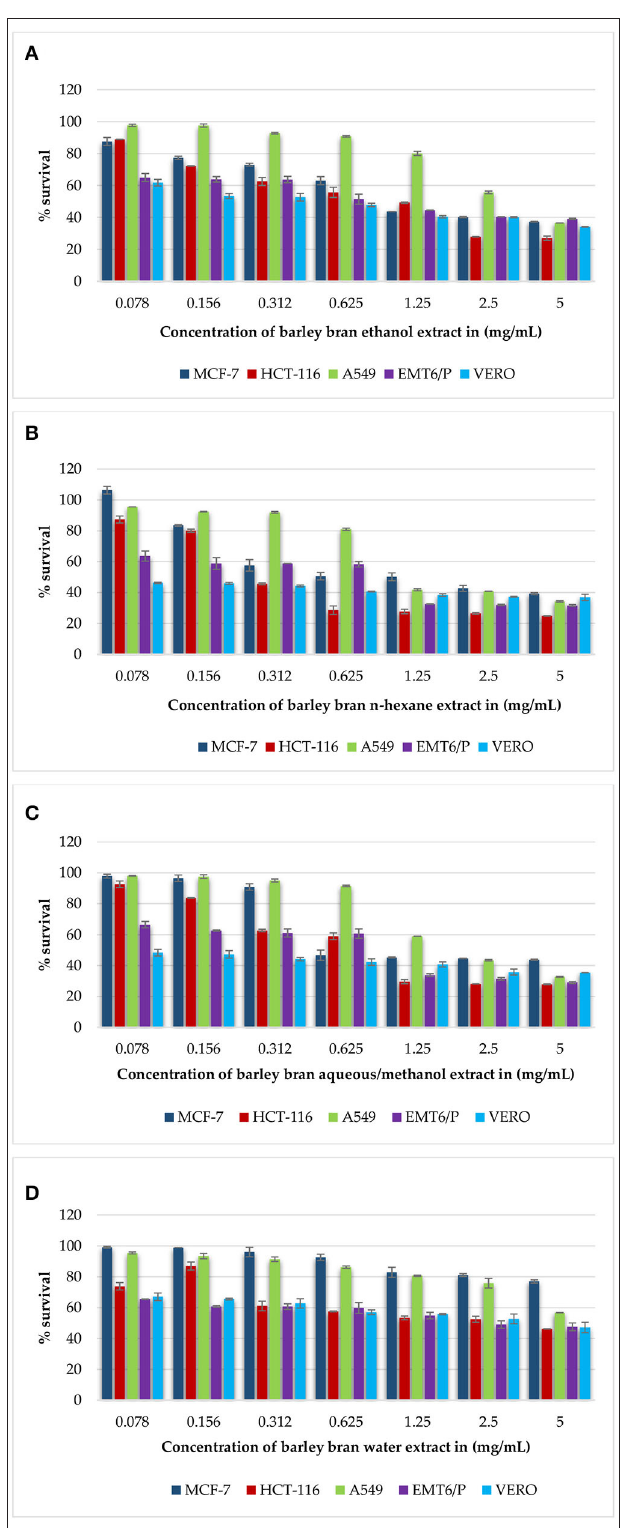
FIGURE 1 | (A–D) Antiproliferative activity of all extracts of barley bran on cancer cell lines (MCF-7, HCT-116, A549, EMT6/P) and on the VERO normal cell line using concentrations between 0.078 and 5 mg/ml. Percentage of cell viability (%) was calculated as (OD of treated cells/OD of control cells * 100). Results are expressed as means of three independent experiments ±